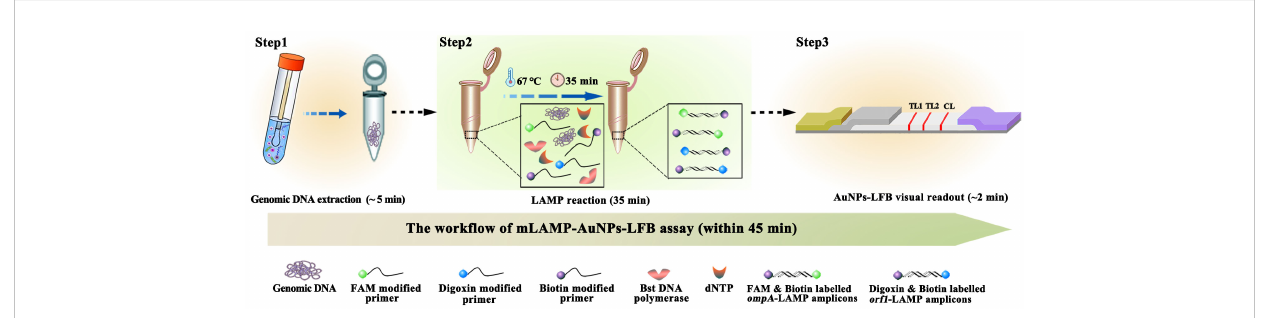
FIGURE 1 mLAMP-AuNPs-LFB assay work fl ow The mLAMP-AuNPs-LFB assay ’ s work fl ow includes genomic DNA extraction (5 min), mLAMP reaction (35 min), and AuNPs-LFB visual readout (<2 min) and can be completed within 45